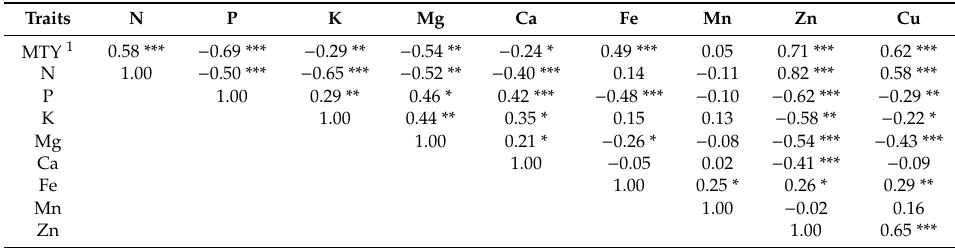
Table A2. Correlation matrix of relationships between nutrients in potato leaves and MTY ( n =